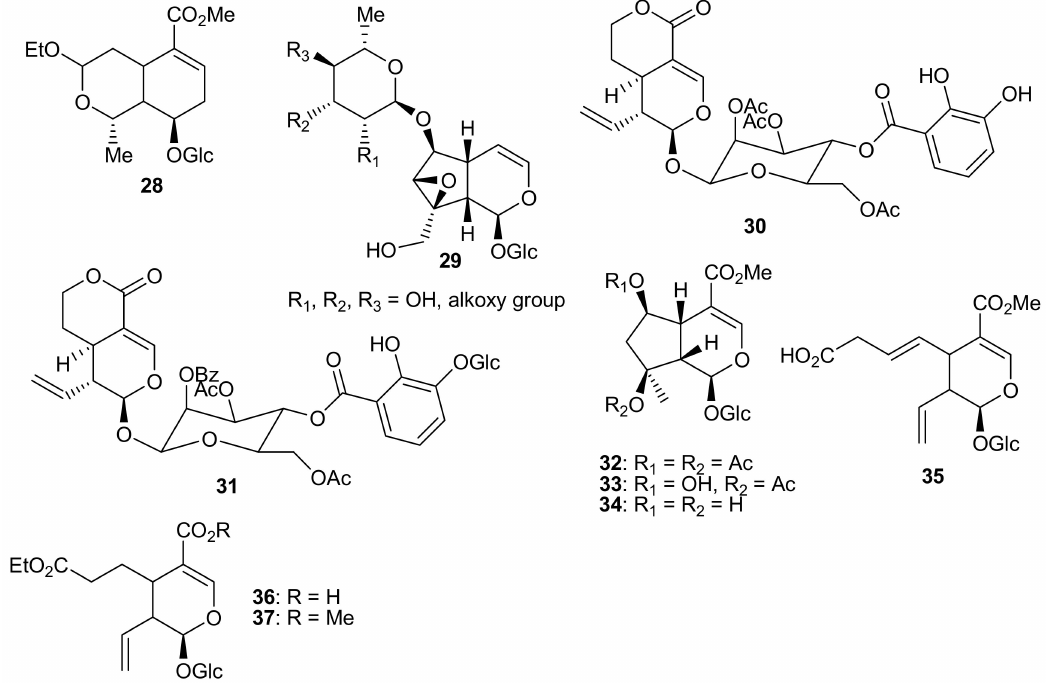
Figure 6. Structures of iridoids 28 – 37